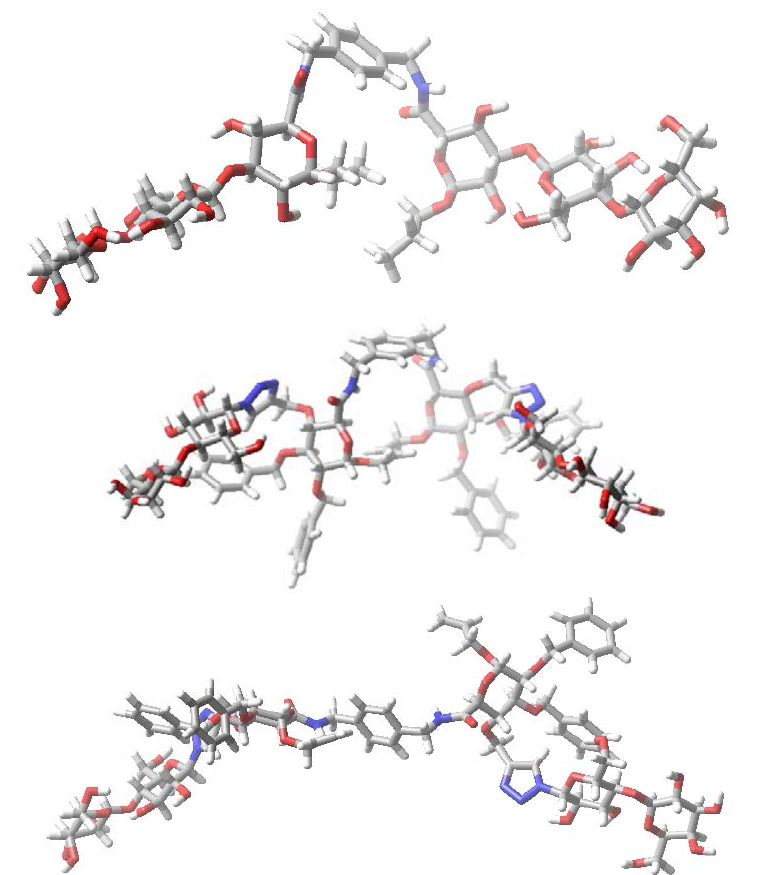
Figure 8. Models of lactose-bearing compounds 6 (top), 7 (middle) and 8 (bottom) in extended